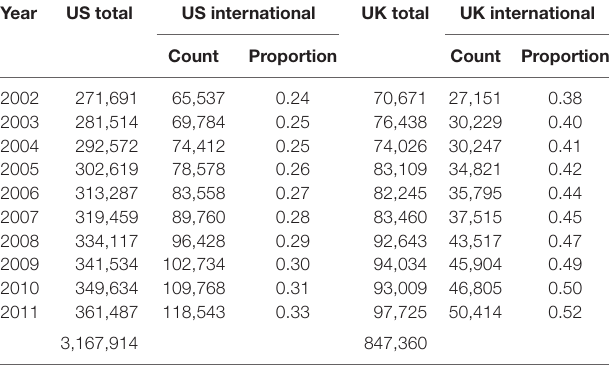
TaBle 1 | The number of papers (articles and reviews) for the US and for the UK with at least one domestic author and the number and proportion of those papers with one or more international addresses, from journals indexed on Thomson Reuters Web of